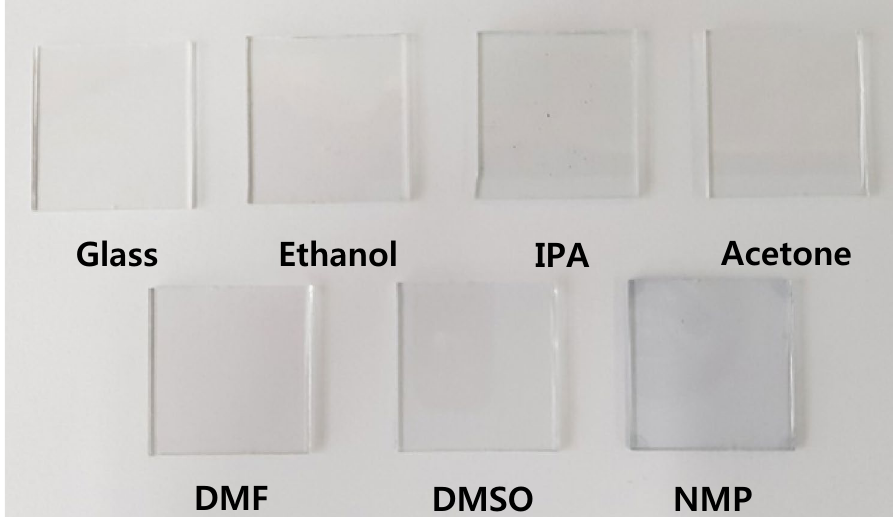
Figure 1. Graphical images of the PANI passivation layer (PPL), based on the solvent used.